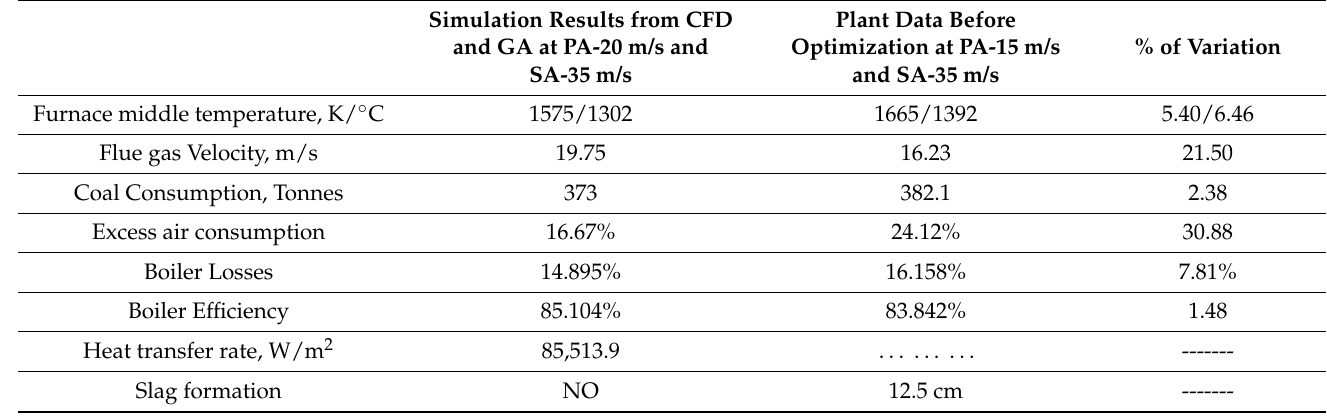
Table 12. Comparison of Simulation results with un-optimized physical plant data. Simulation Results from CFD